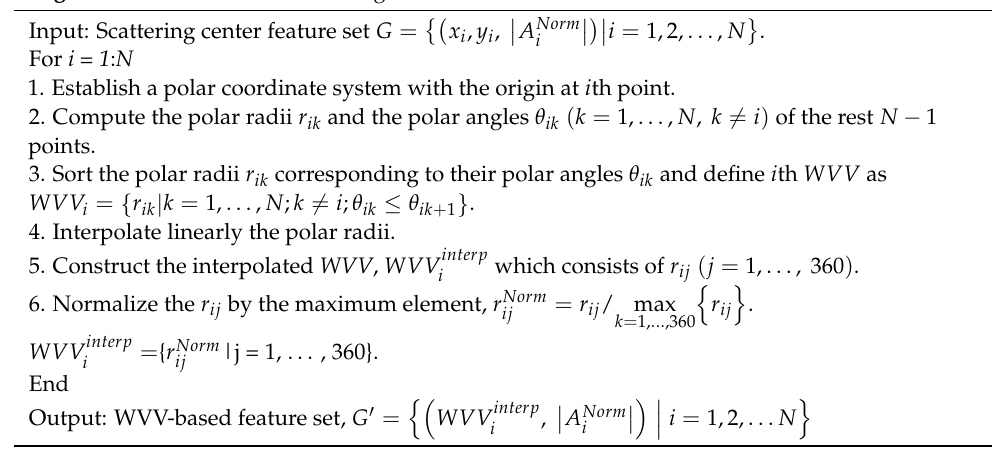
Algorithm 1: WVV-based scattering center feature reconstruction